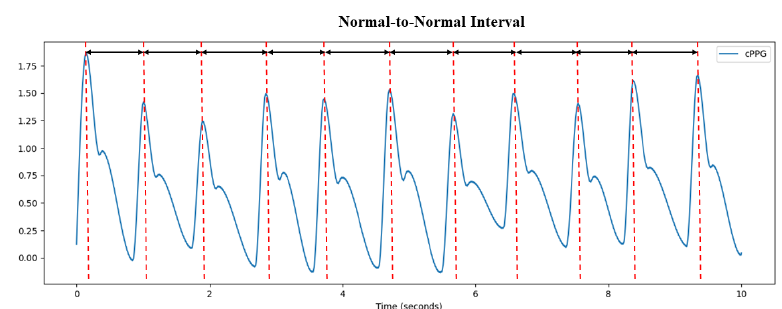
Figure 3. Normal-to-normal interval (NNI) obtained from rPPG